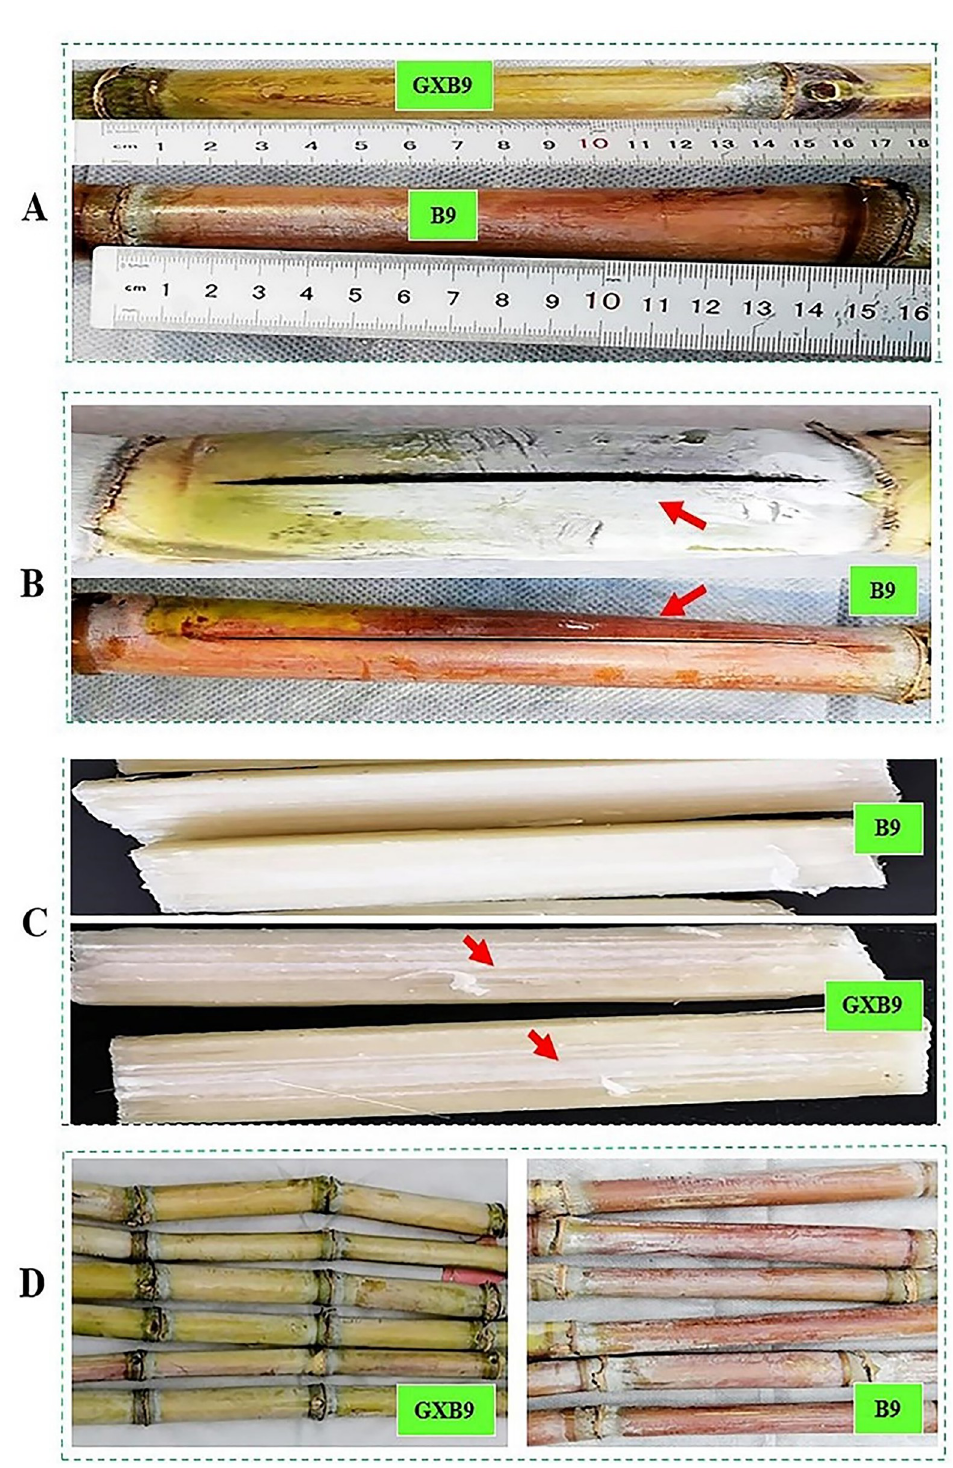
Fig 6. Internode characteristics in GXB9 and B9. A , internode length; B , growth crack; C , internal view of internode; D , internode color.